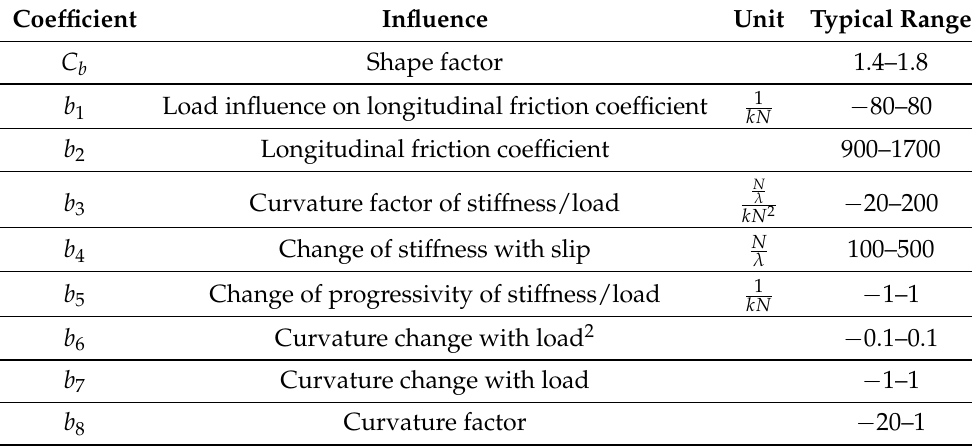
Table 2. Longitudinal coefficients for dry